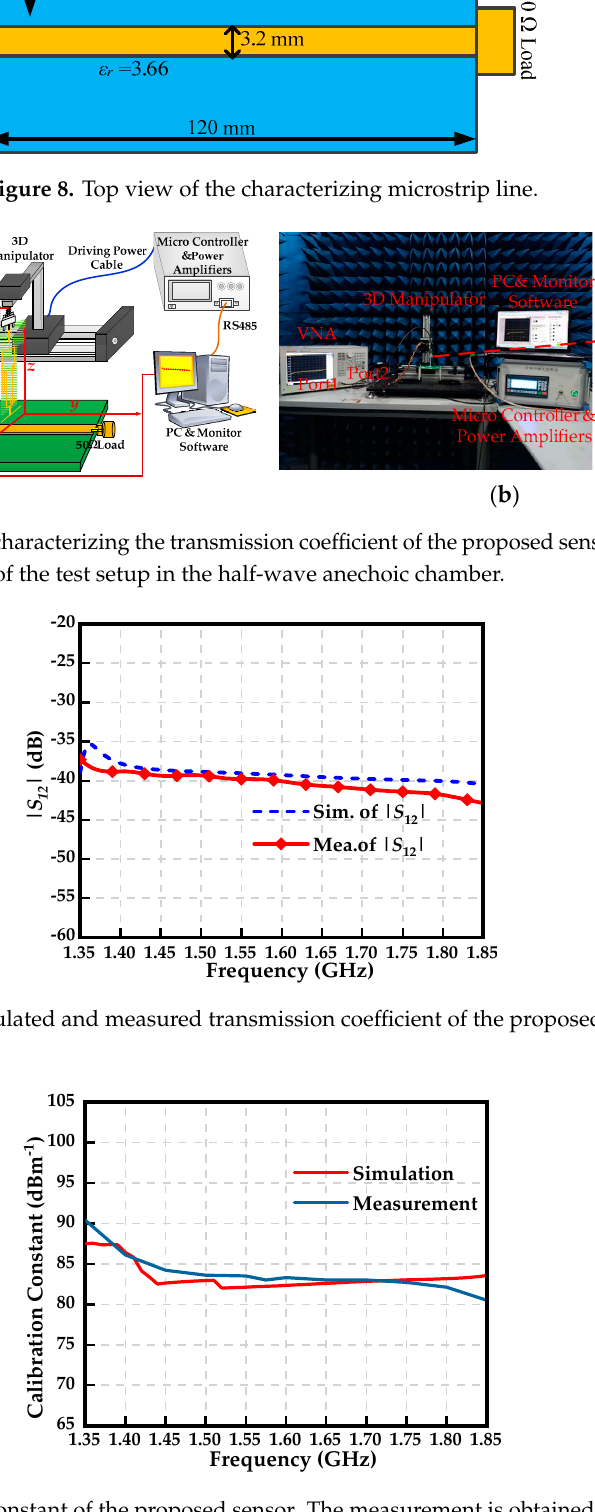
Figure 11. Calibration constant of the proposed sensor. The measurement is obtained with the use of a signal generator and spectrum